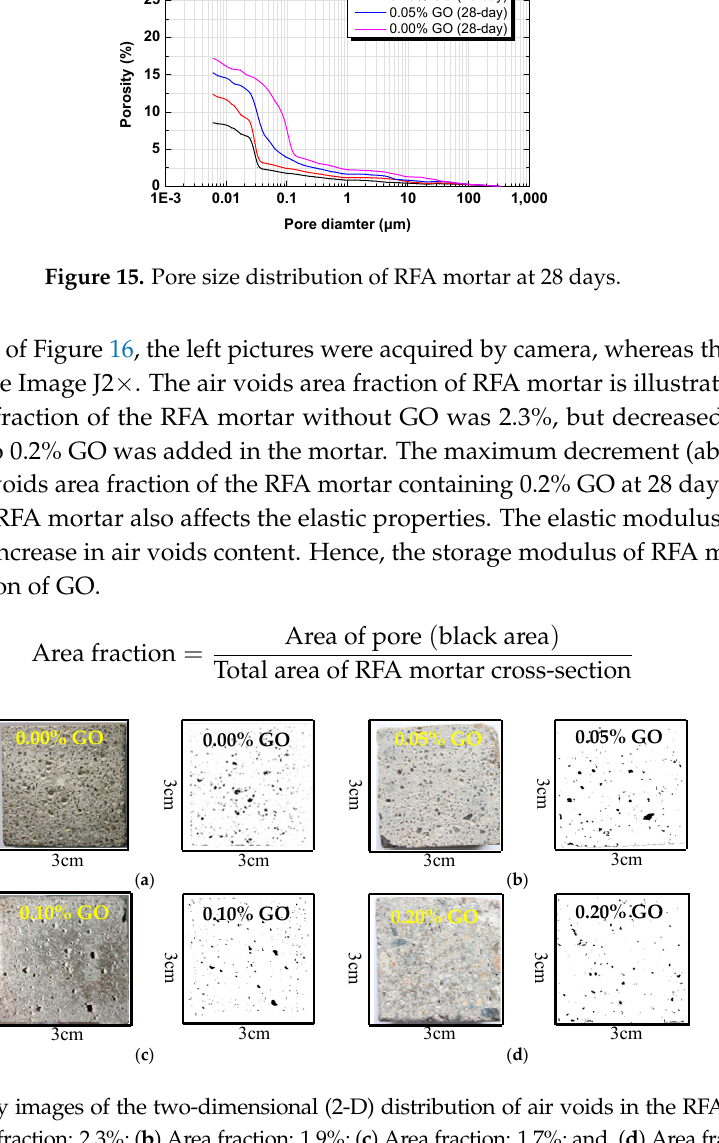
Figure 16. Binary images of the two-dimensional (2-D) distribution of air voids in the RFA mortars at 28 days. ( a ) Area fraction: 2.3%; ( b ) Area fraction: 1.9%; ( c ) Area fraction: 1.7%; and, ( d ) Area fraction: 1.4%.